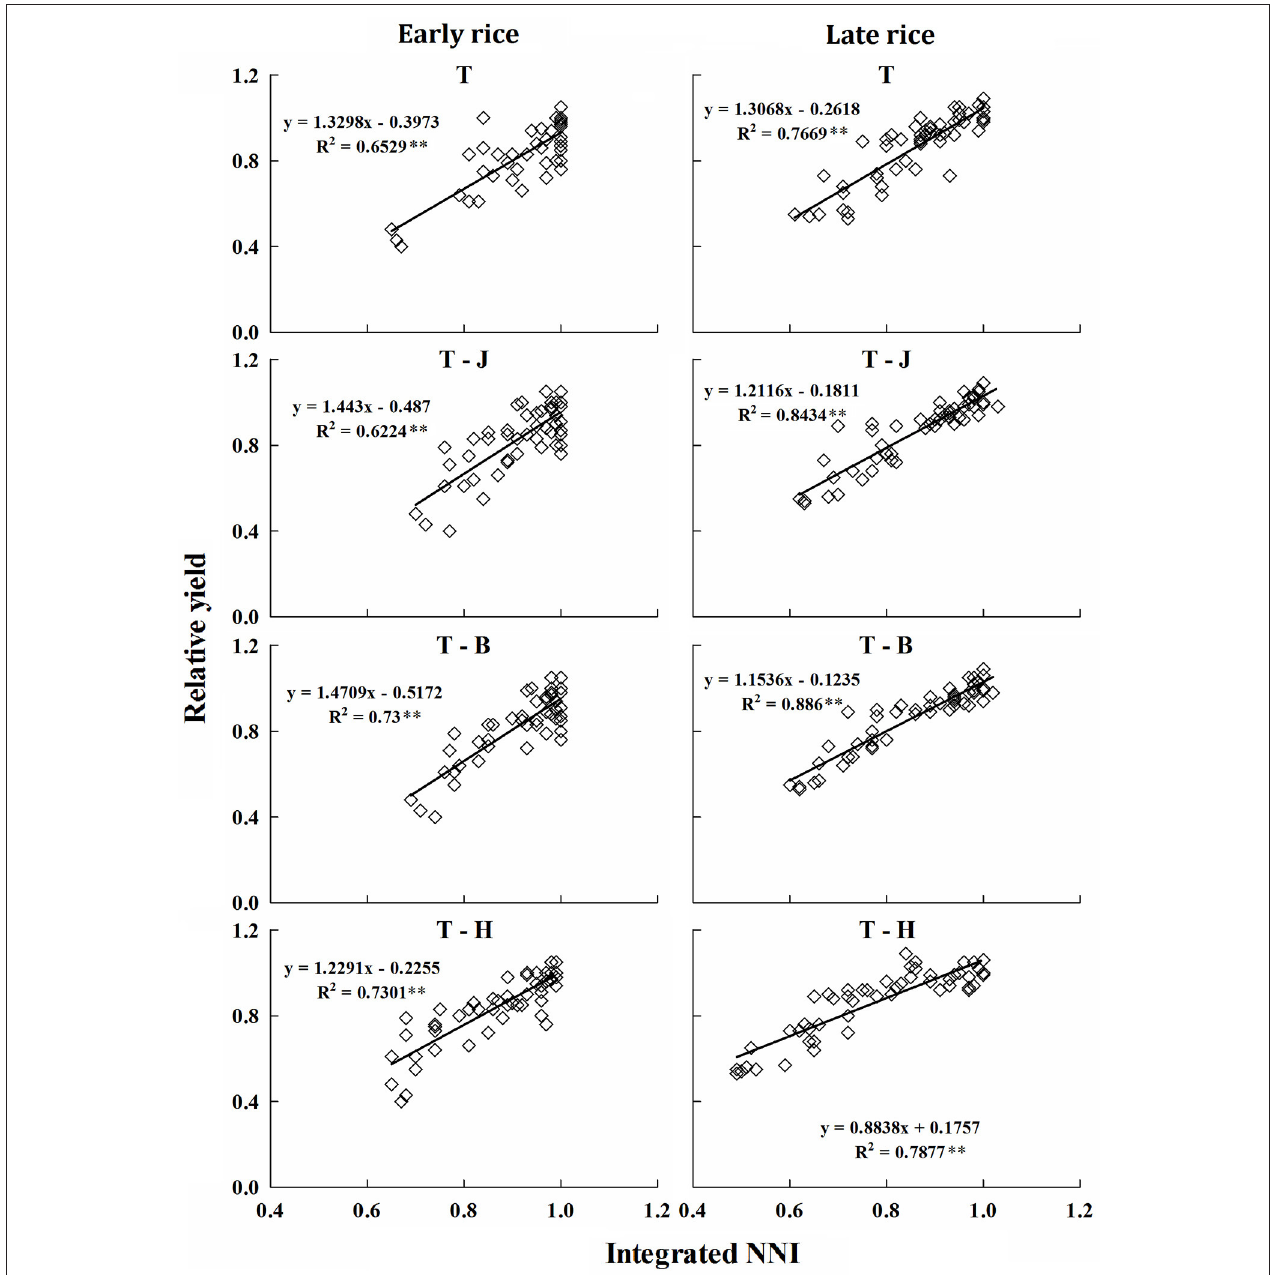
FIGURE 6 | Relationship between NNI int and RY at different growth periods for early and late rice in experiments conducted during 2013 and 2014. The T, J, B, and H represent growth stage of tillering, jointing, booting and harvest respectively. **Significant at p <